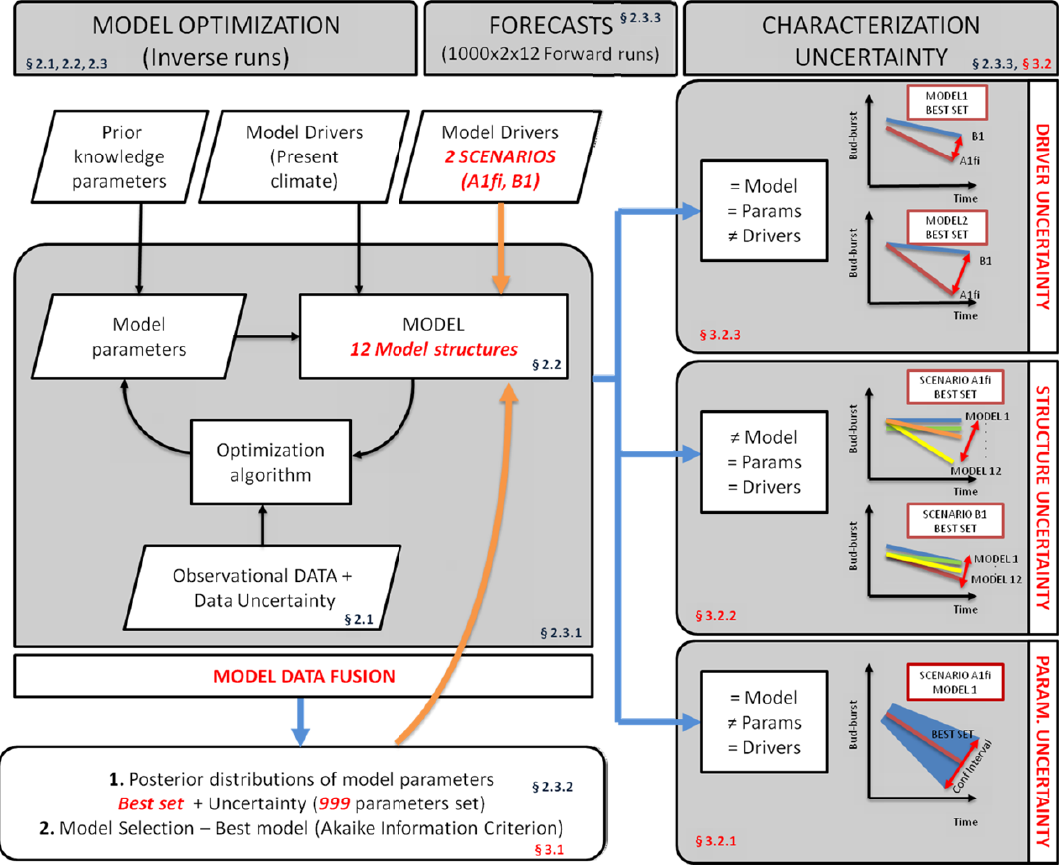
Fig. 1. Schematic representation of the model-data fusion approach for model optimization, the forecat mechanism and the characterization of the three sources of uncertainty. In each box is reported the paragraph where the description of methods (blue characters) and results (red characters) can be found. The schematic representation of the effects of the different uncertainties on bud-burst projections is also